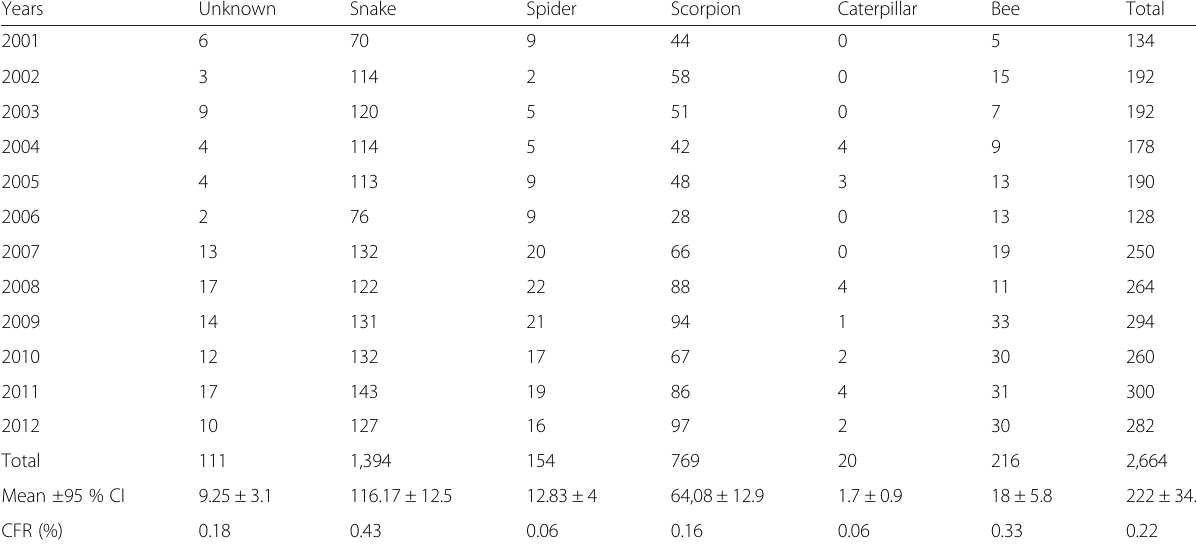
Table 2 Yearly number of deaths caused by envenomation in Brazil, 2001-2012 Years